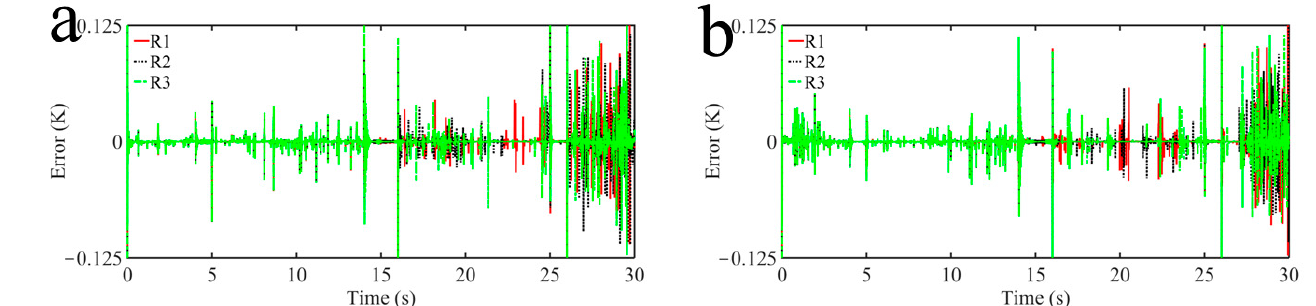
Figure 33. Simulation results with the measurement noises: ( a ) the tracking errors of Wall 2_45 mm for composite controller; ( b ) the tracking errors of Wall 2_85 mm for composite controller.